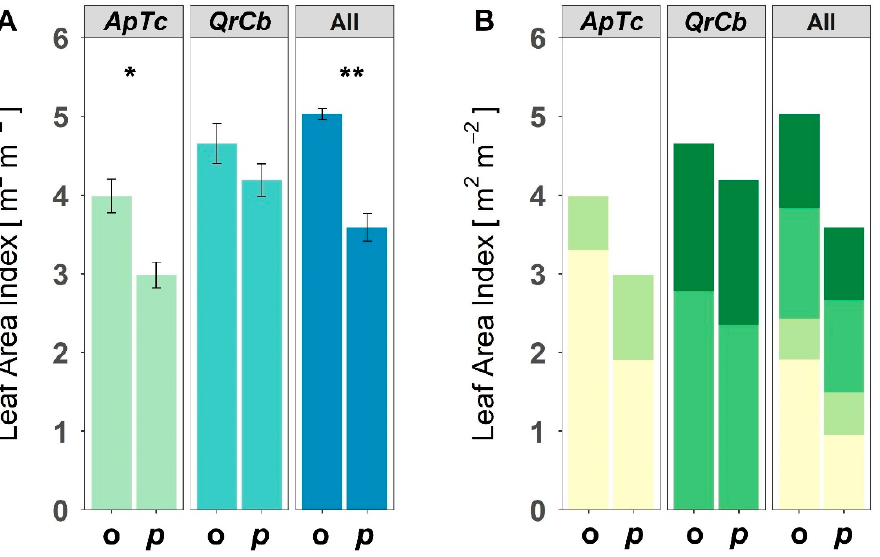
Figure 3. ( A ) Observed (o) and predicted ( p ) leaf area index (LAI) and ( B ) the contribution of each species to the LAI in two species polycultures ( ApTc , QrCb ), and the four species polyculture (All) of the four species A. platanoides ( Ap ), T. cordata ( Tc ), Q. robur ( Qr ), C. betulus ( Cb ). Shown are means and standard error of the LAI. Asterisks show significant differences determined using an unpaired t-test (* p < 0.05; ** p < 0.01). Table 1. Corresponding ANOVA results for the plot-wise LAI results shown in Figure 2 (one-way ANOVA).